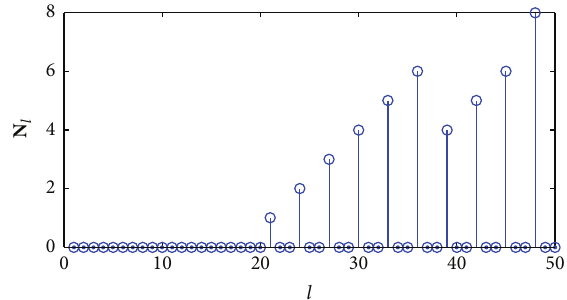
Figure 3: The recorded vector N 𝑙 based on correct synchronization.